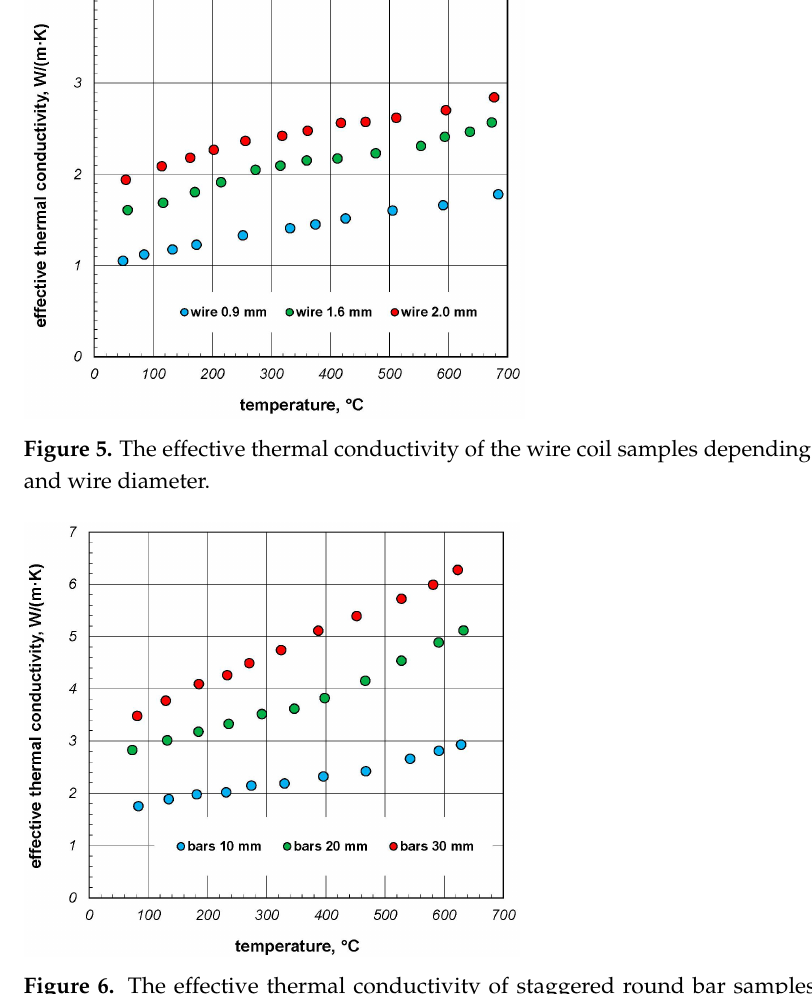
Figure 6. The effective thermal conductivity of staggered round bar samples depending on the temperature and bar diameter.